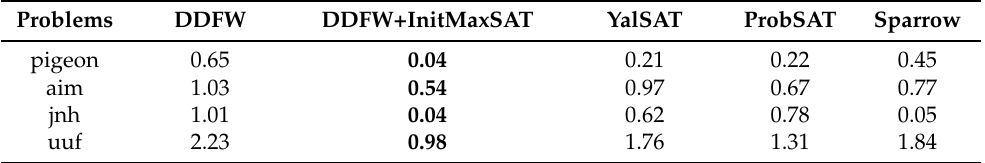
Table 2. Average results of the problem set on 1000 run for each solver; the CPU time recorded for each solver when reaching the optimum solution (maximum number of satisfied clauses).